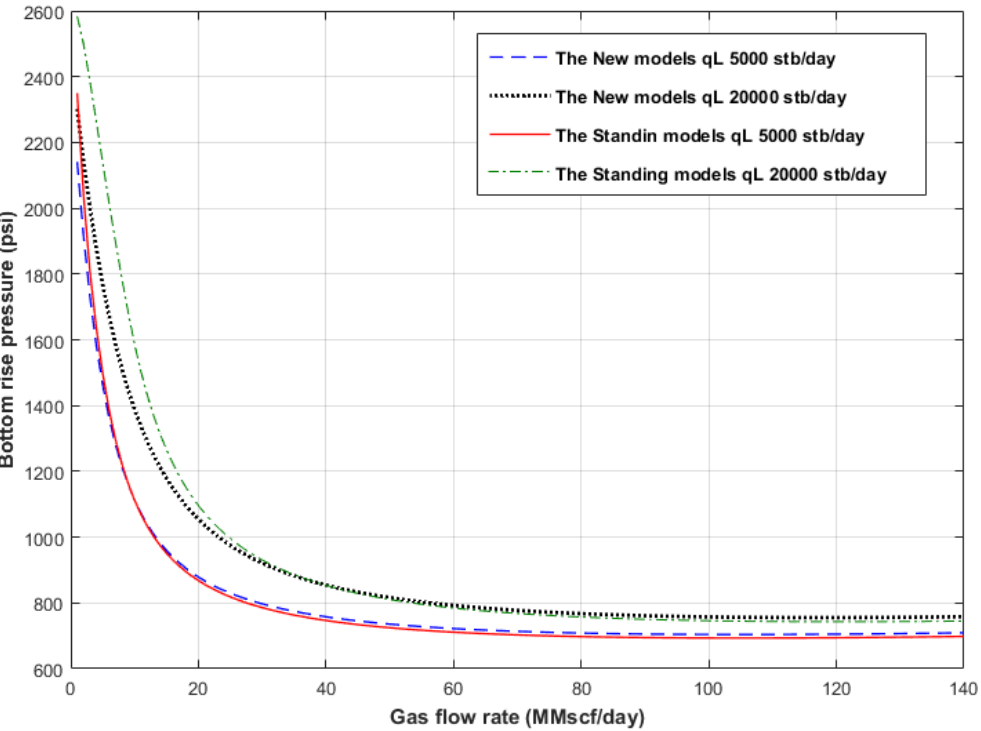
Figure 11. Simulation of bottom hole pressure versus gas injection rate for the new models and the Standing correlations.